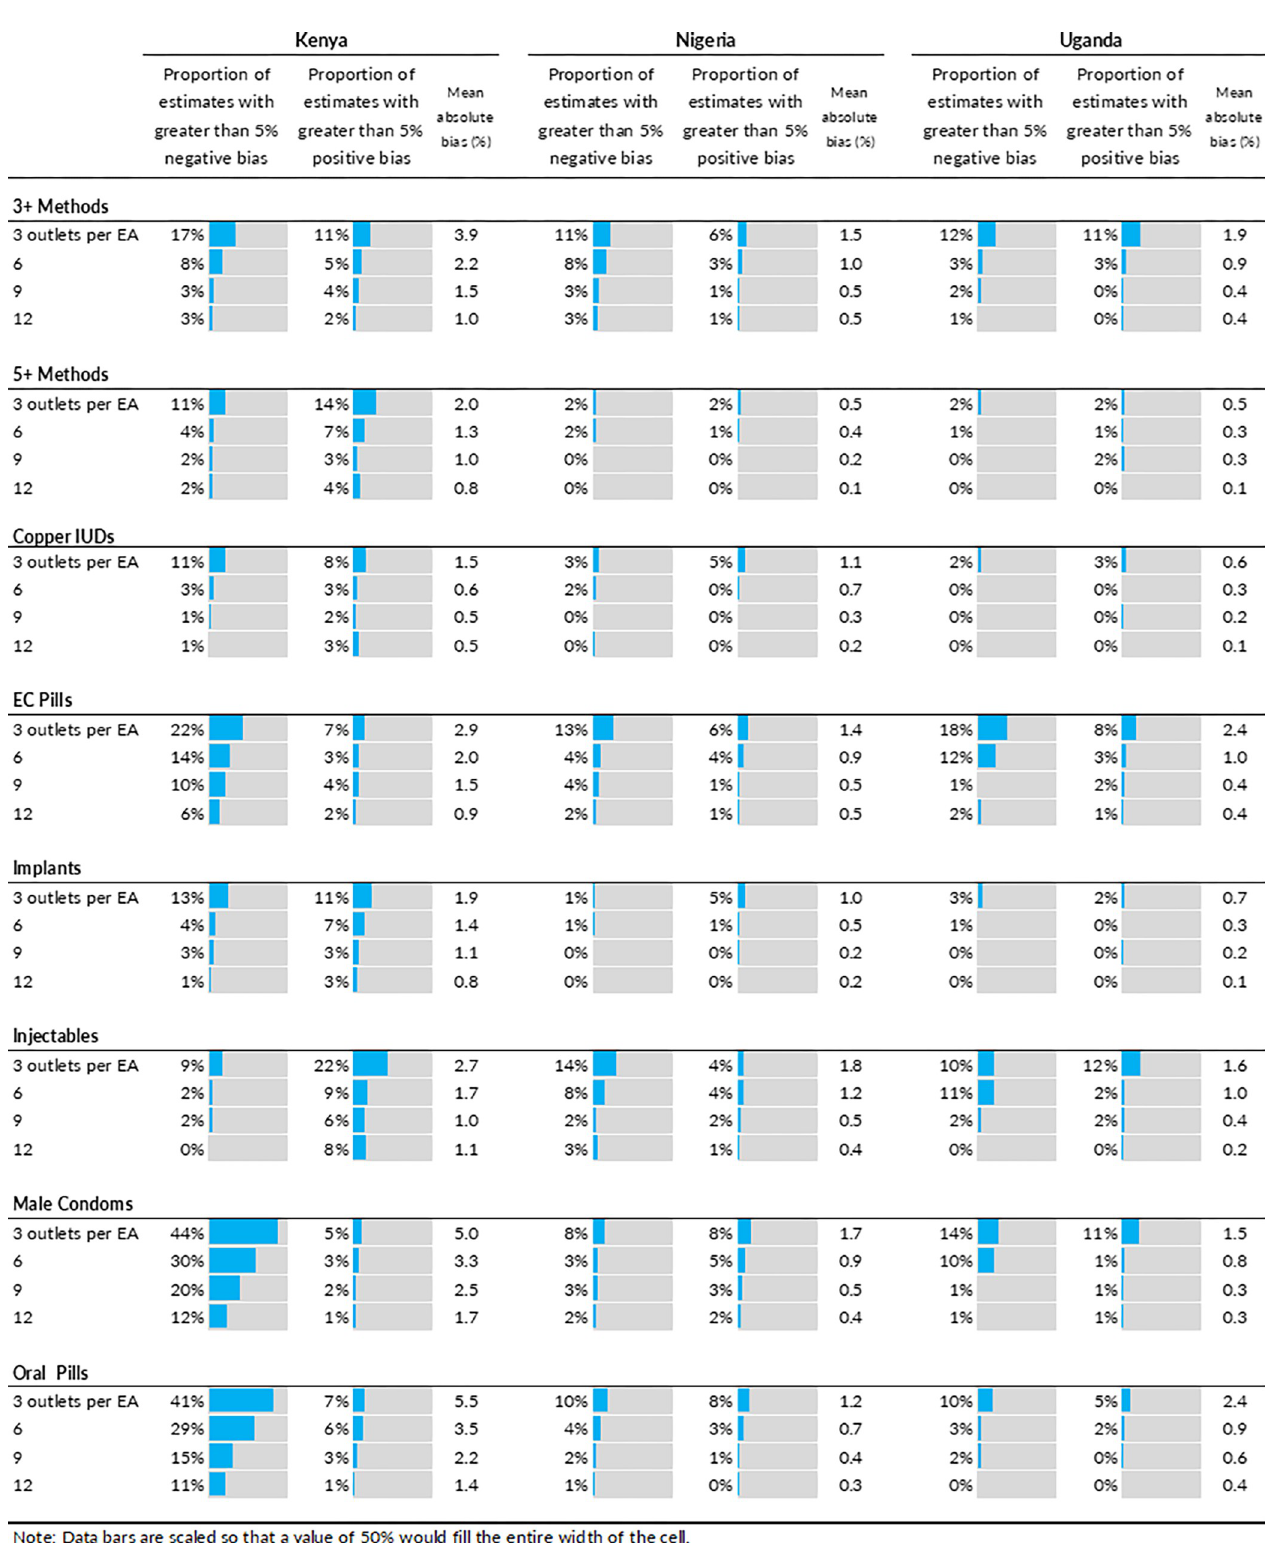
Fig 7. Proportion of round 1 simulated product availability estimates with bias of greater than 5%. The proportion of simulated estimates that were biased negatively by 5% or more and positively by 5%, as well as the mean absolute bias, is presented by country for each of the product availability indicators and for